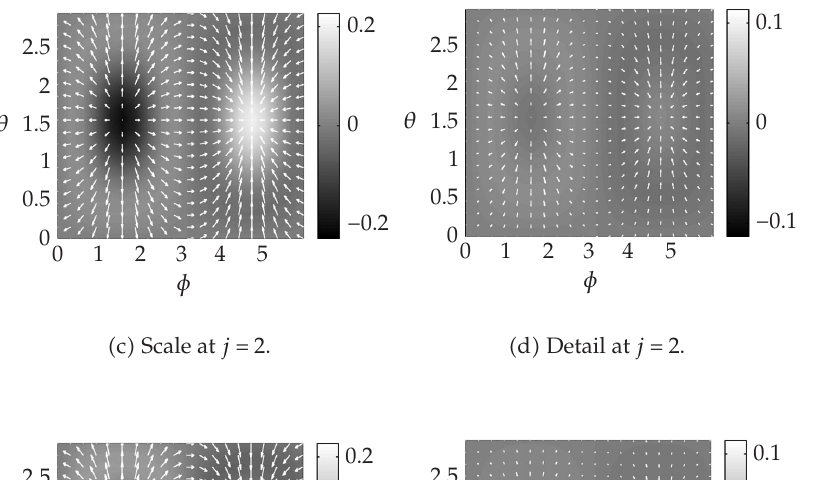
( b ) Detail at j = 1.